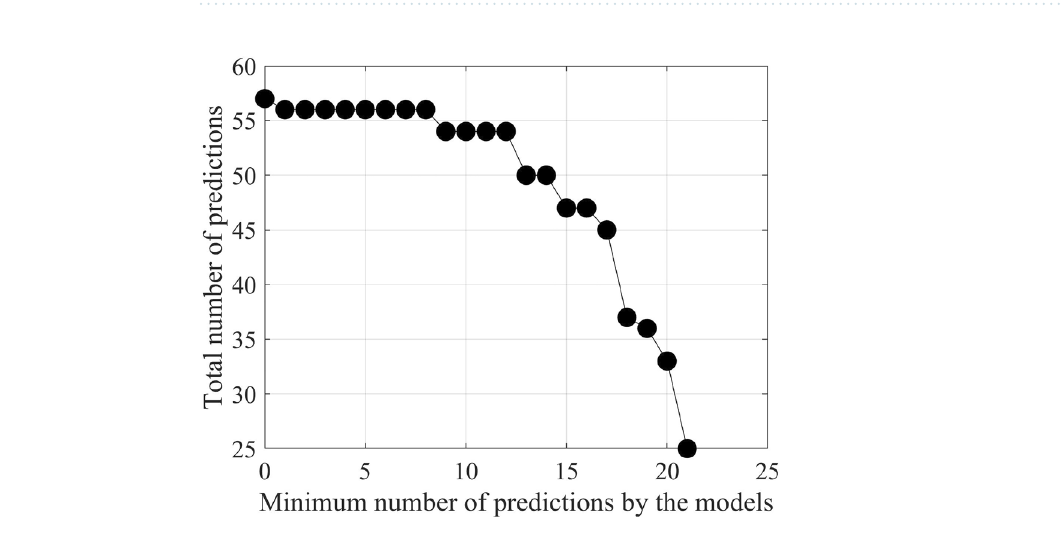
Figure 12. The process of finding the threshold for the new test dataset from